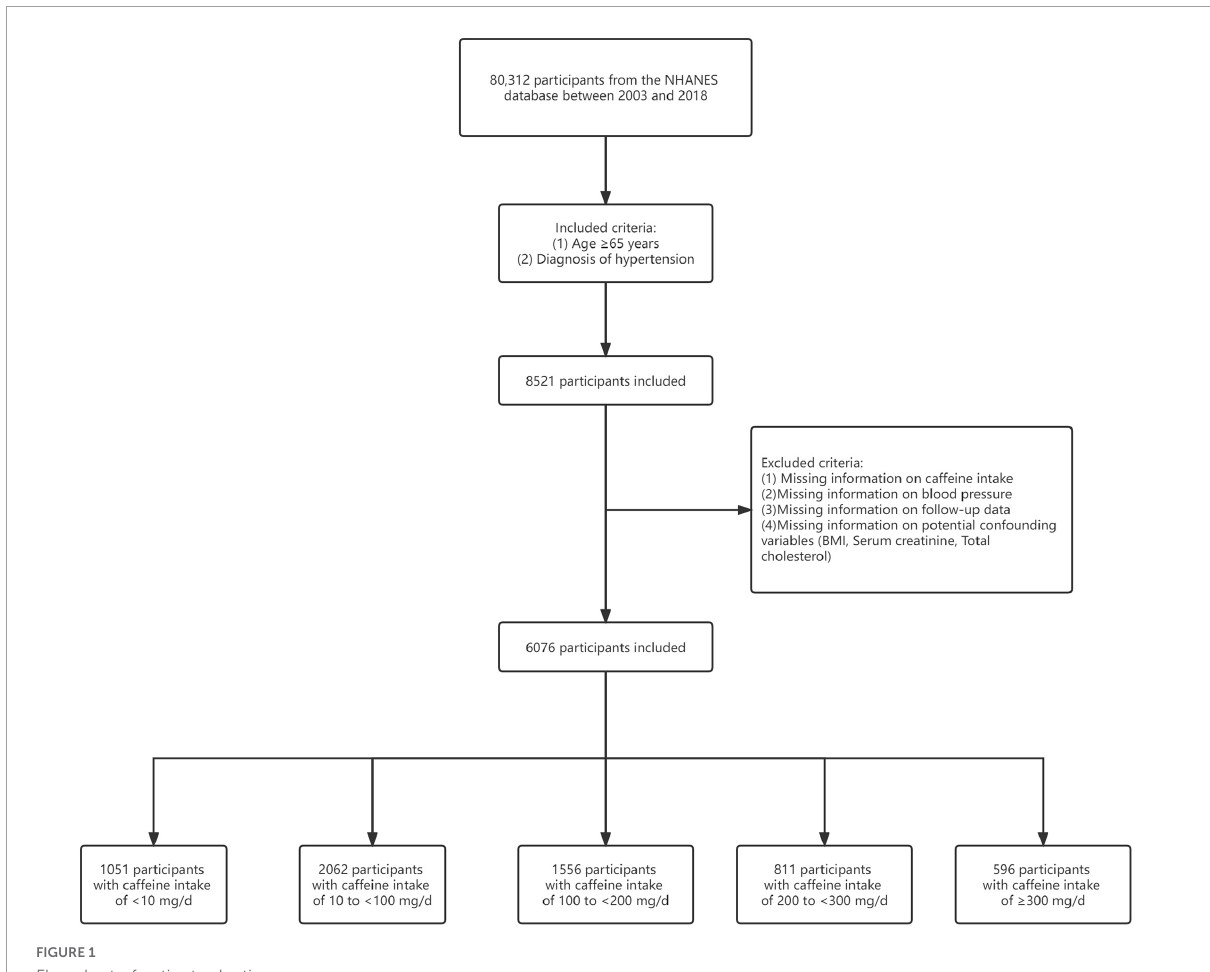
FIGURE1 Flowchart of patient